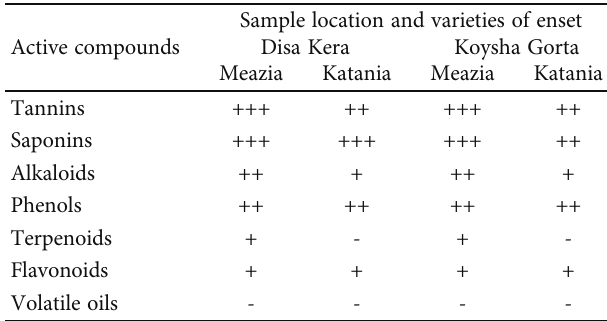
Table 1: Phytochemical screening of the Meazia and Katania varieties of two di ff erent